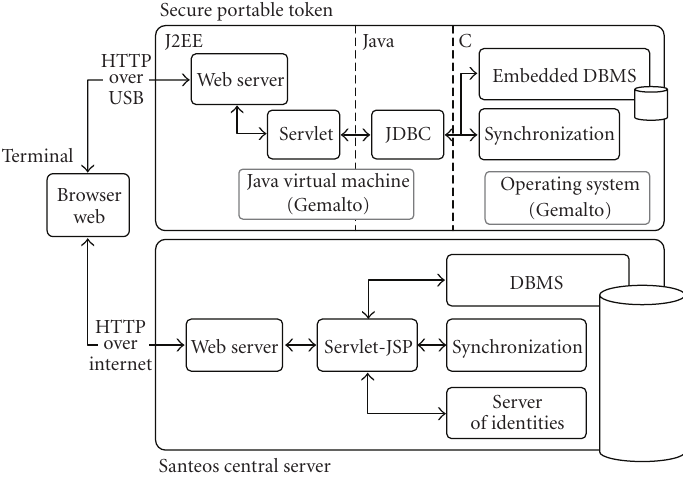
Figure 4: Software